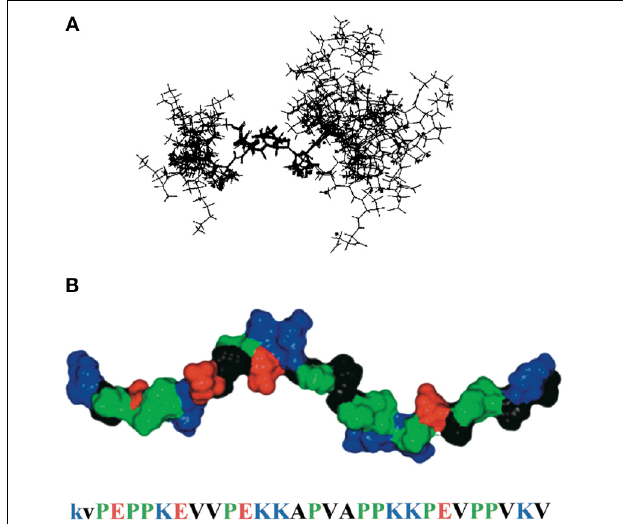
FIGURE 4 | PEVK structure. (A) NMR ensemble of a 12-residue region of PEVK, showing both the polyproline type II helix and flanking unstructured regions. (B) model of the PEVK region, joining three short NMR structures together. Residues are colored according to their chemical properties (red is negative charge, blue is positive charge, green is proline, and black is hydrophobic). Reproduced with permission from Ma et al.